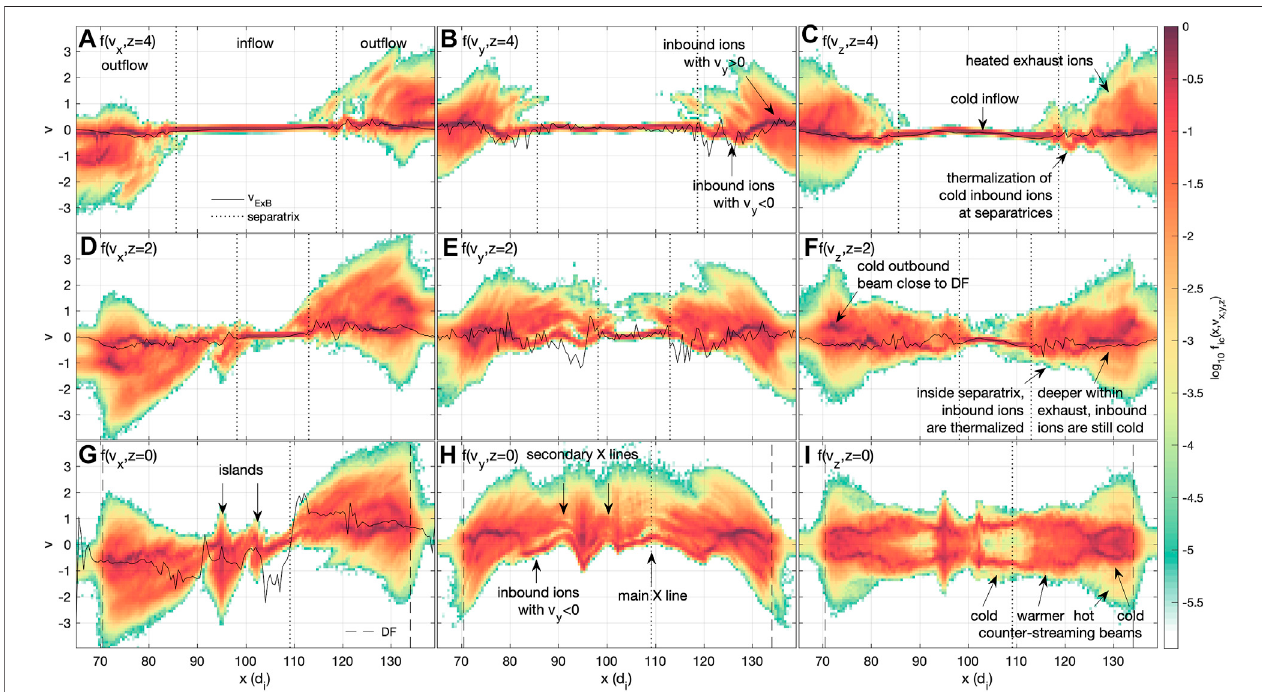
FIGURE 3 | Reduced distributions of initially cold ions at t ω ci (cid:1) 120, at (A – C) z (cid:1) 4, (D – F) z (cid:1) 2, and (G – I) z (cid:1) 0. The vertical dashed lines show the location of the separatrix,whichat z (cid:1) 0mapstotheXline.Thesolidlineshows v E × B .Wedonotshowtheseinpanels (H) and (I) becausetheycontain B x ,whichissmallthere.Whilethe cold ions are most apparent in the in fl ow, they are also present in the out fl ow. In an intermediate region, just inside the separatrices, the cold incoming population is affected by the dynamics at the separatrices, and becomes partly thermalized. This is perhaps most prominently seen in f ( x , v z